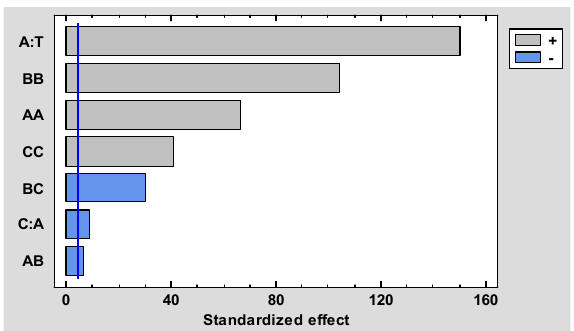
Figure 21. Effect of regression coefficients on color change dE.